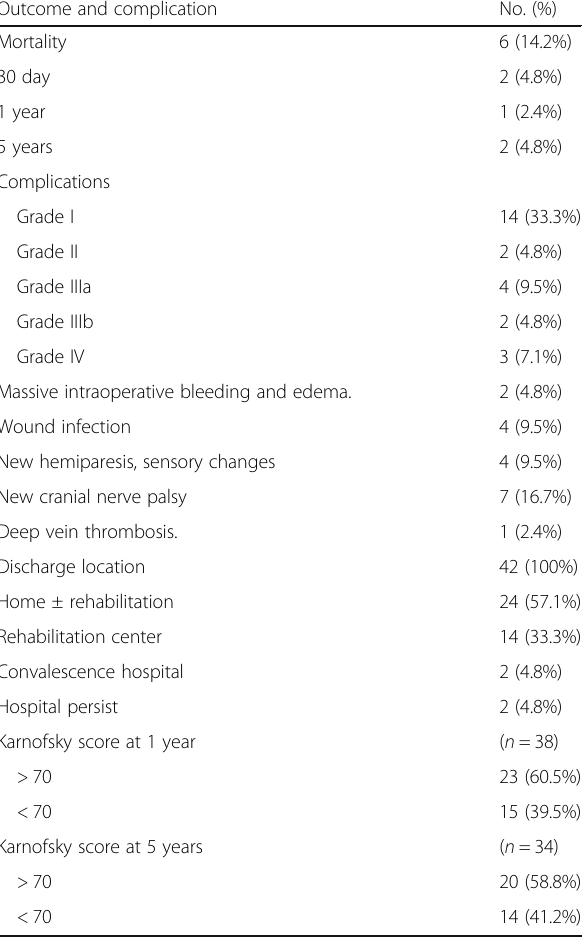
Table 3 Clinical outcomes and complication after surgery Outcome and